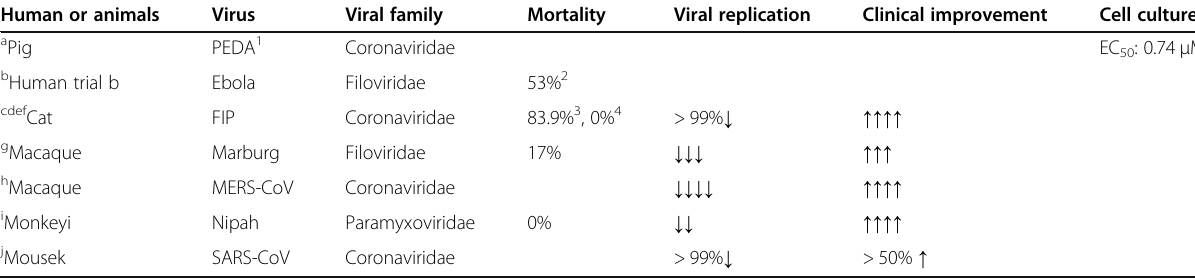
Table 6 Examples of remdesivir in treating other viral diseases Human or